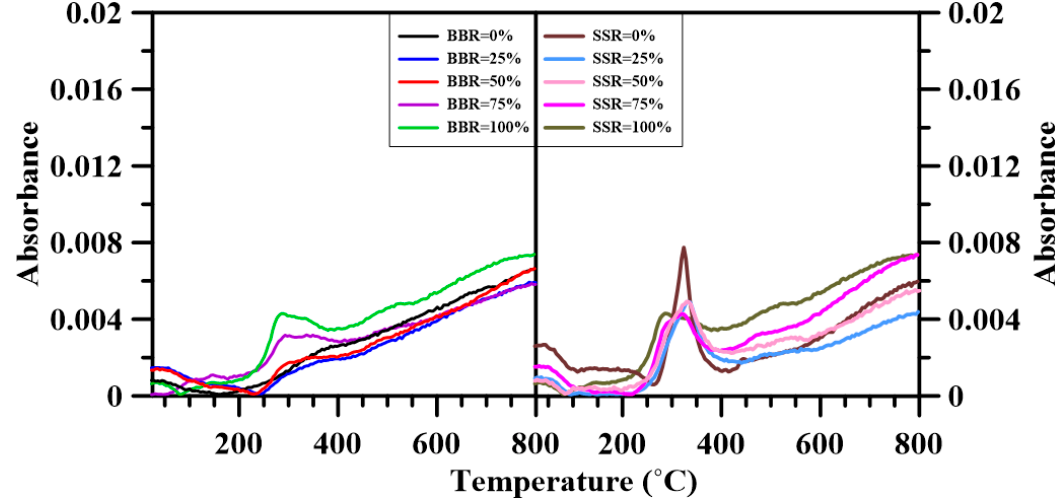
Figure 13. Evolution of NO x for various sludge-coal and sludge-shiitake ratios in TGA-FTIR.